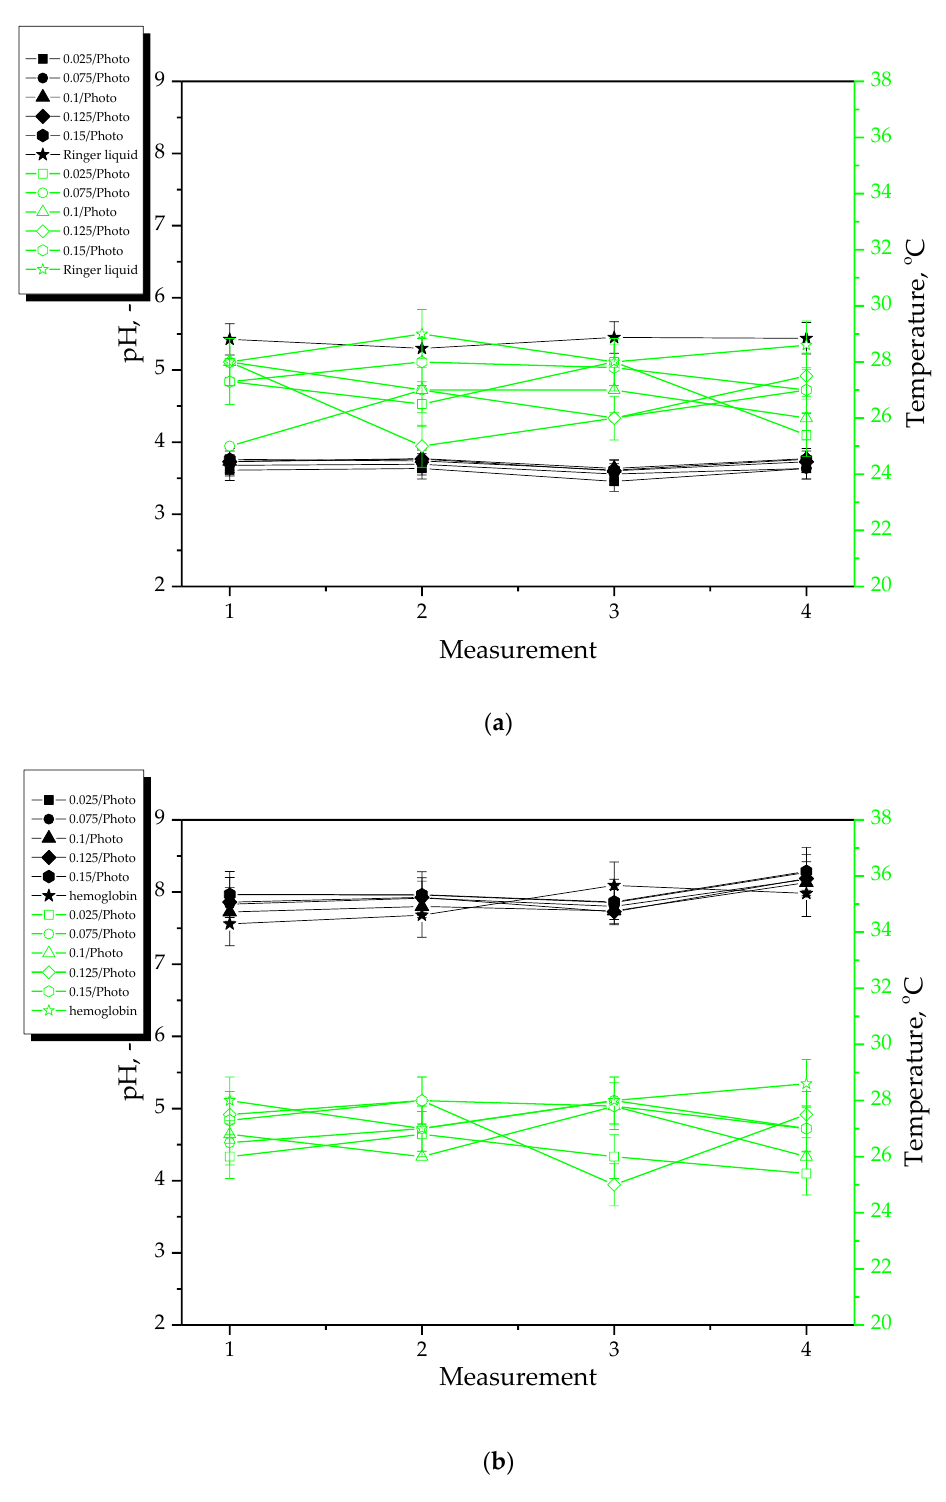
Figure 3. Results of incubation of hydrogels in Ringer liquid ( a ) and hemoglobin ( b ). During 8-day incubation of hydrogel samples, the pH and the temperature of the incubation liquids were measured at two-day intervals. Based on the results of the stud- ies, a clear pH change of Ringer liquid and distilled water was observed. Such a sharp pH decrease at the beginning of the study may indicate the release of the active sub- stances (i.e., Aloe vera juice and vitamin C) from the hydrogel matrix. This, in turn, may